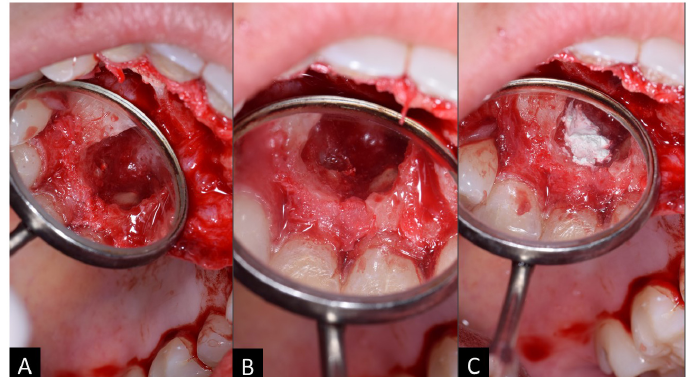
Figure 3. Clinical approach to retro-obturation with five mineral oxides (5MO). A ) Image of the surgical access after washing and polishing the rigid structures with curette; B ) creation of a niche in the apical third for des-obturation; C ) placement of 5MO cement in the retro-obturation.